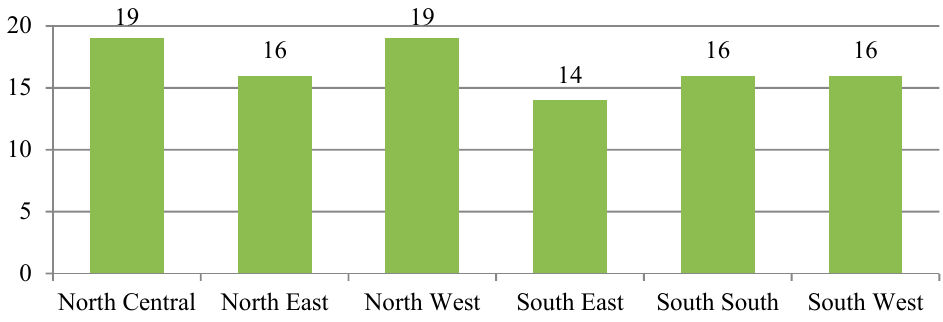
Figure 2 . Share of CIQI cities by geopolitical zones (percentage).